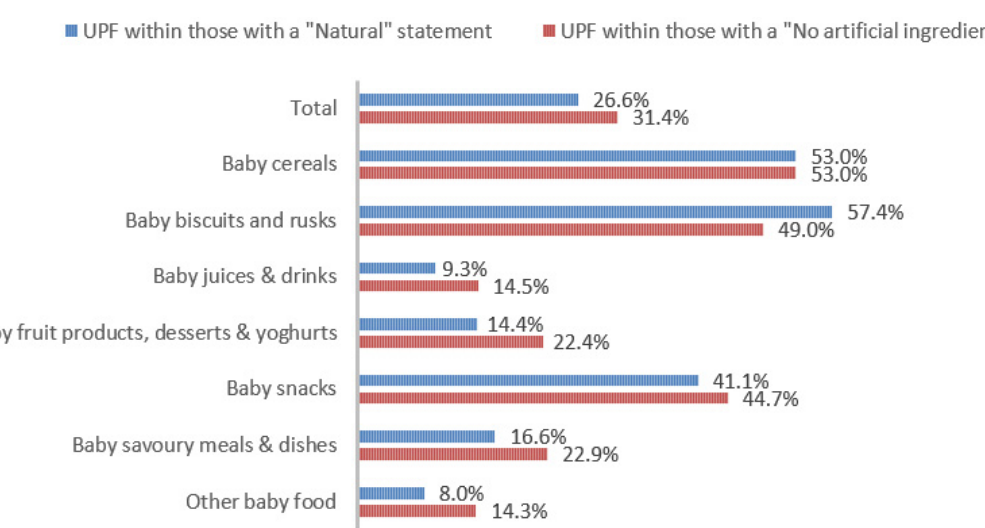
Figure 2. Percentage of ultra-processed foods (UPFs) within products that had a ‘natural’ ( n = 3093) or ‘no artificial ingredient’ ( n = 1578) positioning statement. The ‘no artificial ingredient’ category includes all products that had at least one statement about being free of ‘artificial additives’, ‘artificial colourings’, ‘artificial flavourings’ or ‘artificial preservatives’.